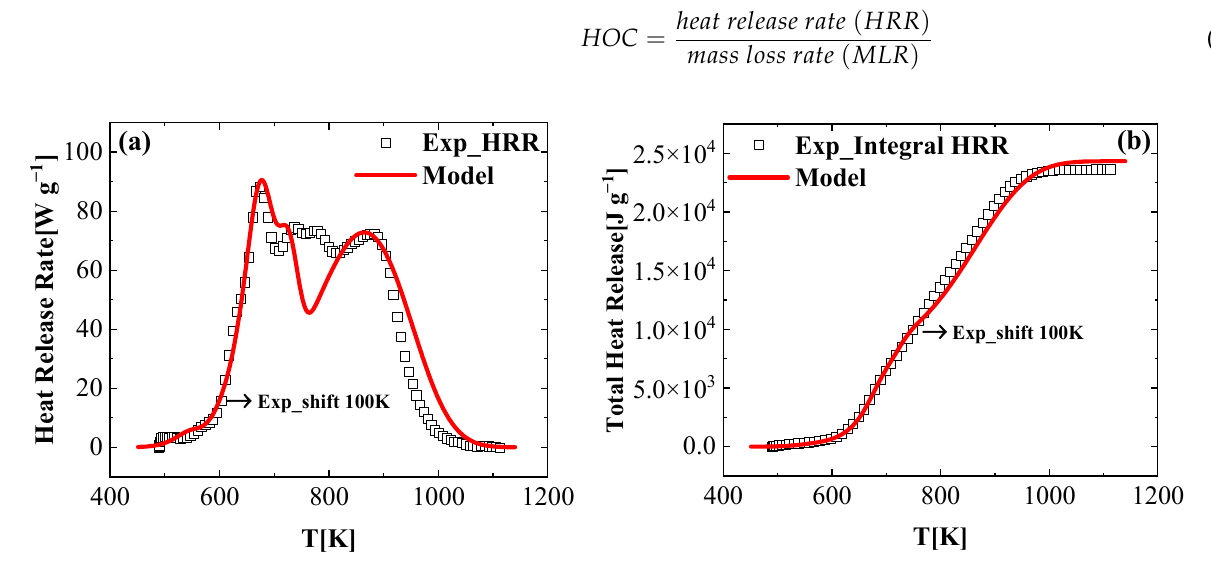
Figure 8. Experimental and simulated ( a ) heat release rate and ( b ) total heat release as a function of the temperature, obtained at a heating rate of 60 K min − 1 . Table 4. Heat of the combustion of the gaseous decomposition products.